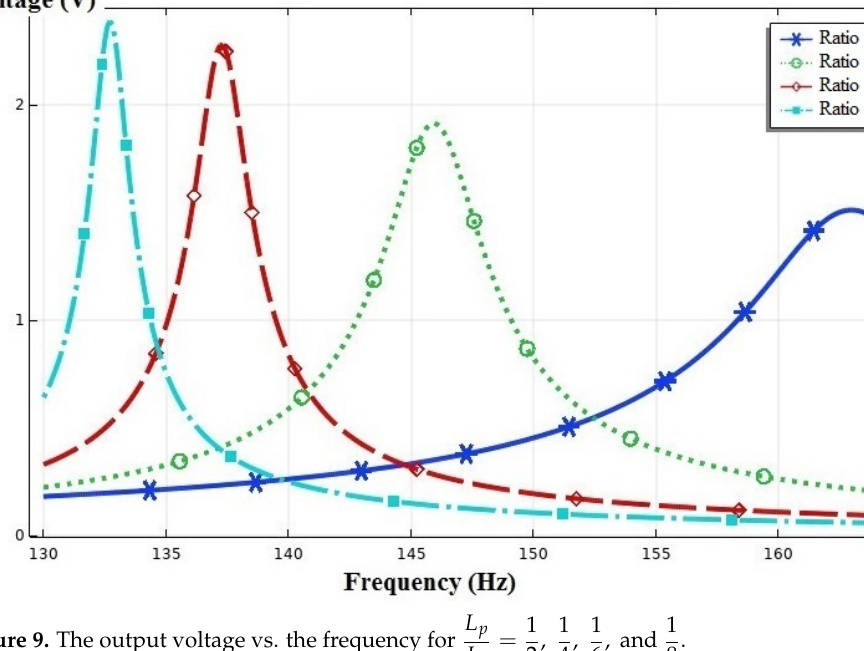
Figure 9. The output voltage vs. the frequency for